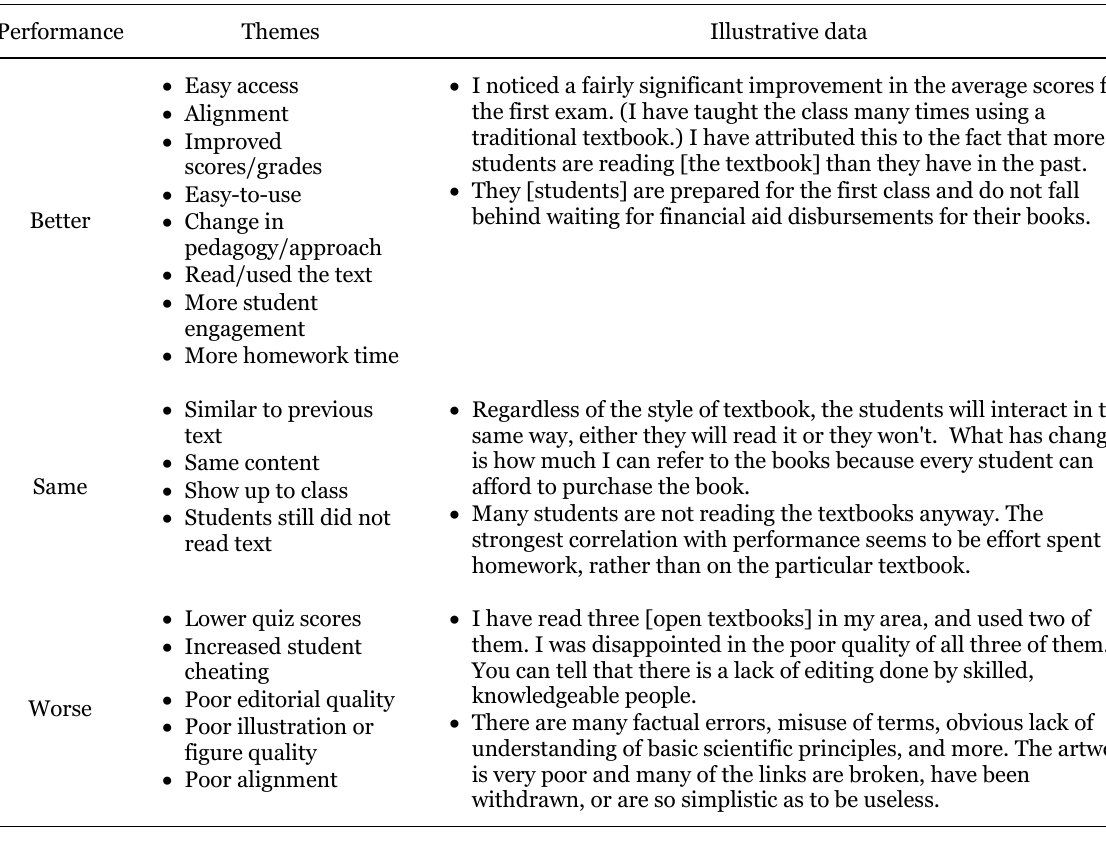
Thematic Analysis on Student Performance Related to Using Open